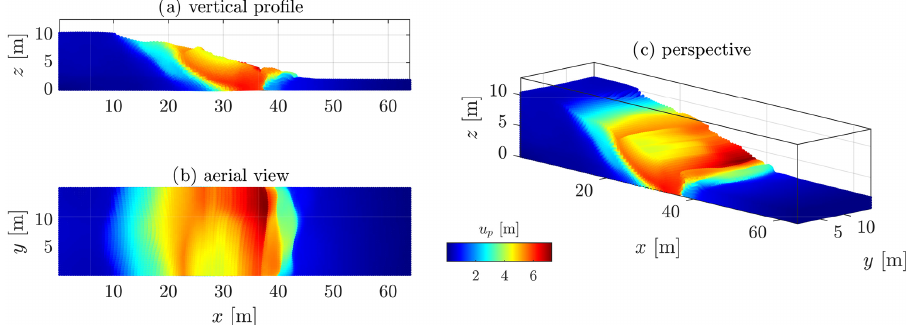
Figure 20. Displacement field obtained after t = 15s for a heterogeneous peak cohesion field with a Gaussian covariance function.